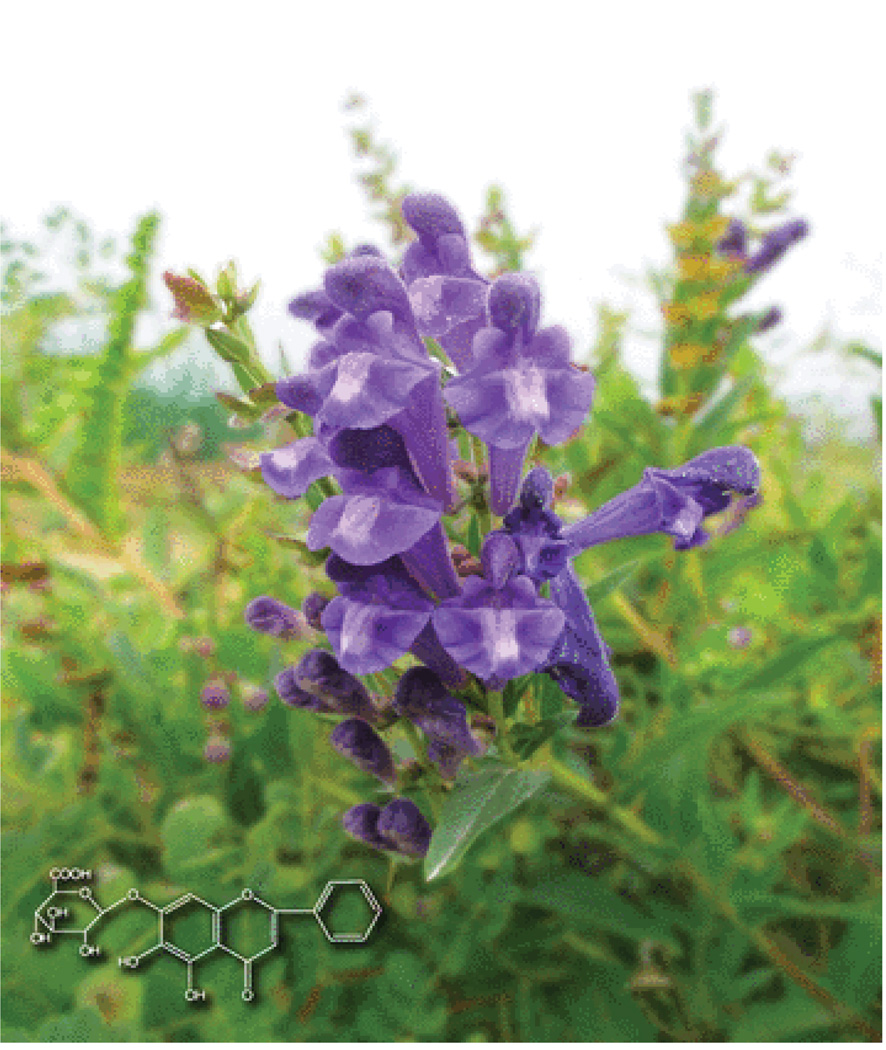
Baikal skullcap (Scutellaria baicalensis) [30].